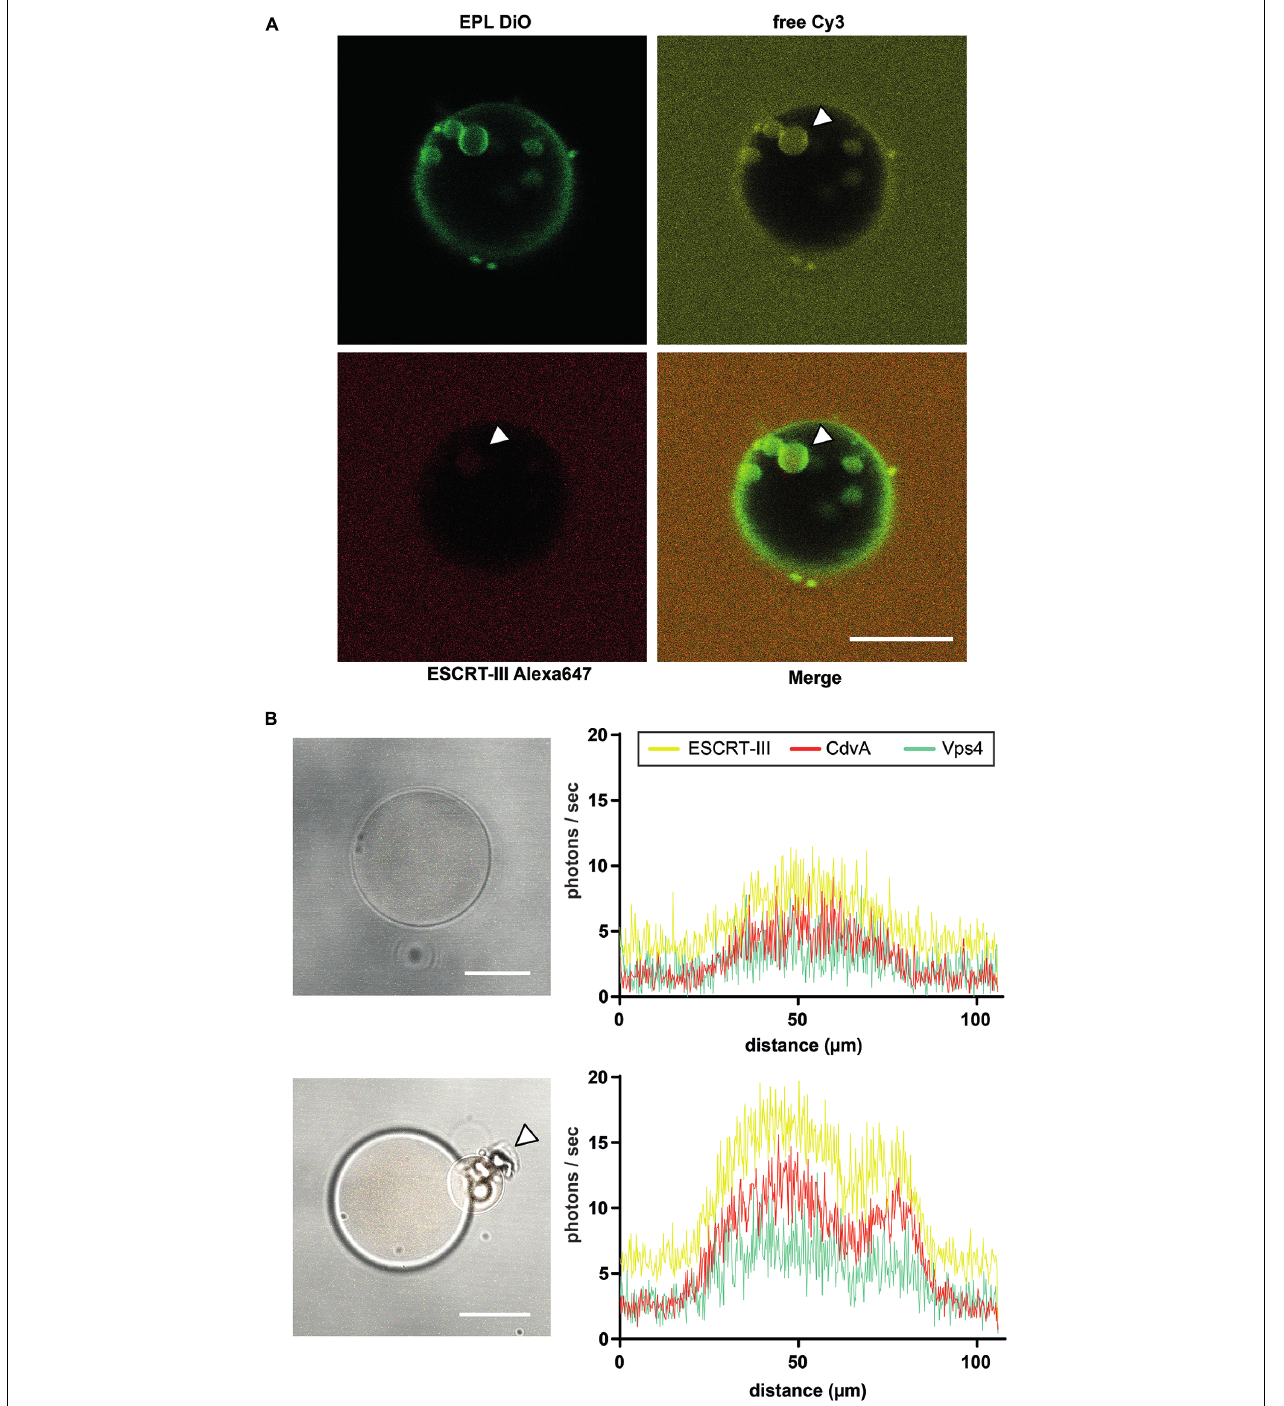
FIGURE 2 | Liposome preparation for intraluminal experiments. (A) ILV formation into EPL ( Escherichia coli polar lipids) GUVs in presence of ESCRT-III and Vps4. The GUV membrane is stained green with DiO. Red labeled ESCRT-III proteins (Alexa647), unstained Vps4 proteins and free Cy3 were added to the extraluminal buffer of the EPL GUVs. After ILV formation of the GUV membrane ESCRT-III as well as the soluble marker Cy3 could be visualized in the vesicles (white arrowheads). Scale bar, 10 μ m. (B) De novo protein production in GUVs via protein synthesis kit